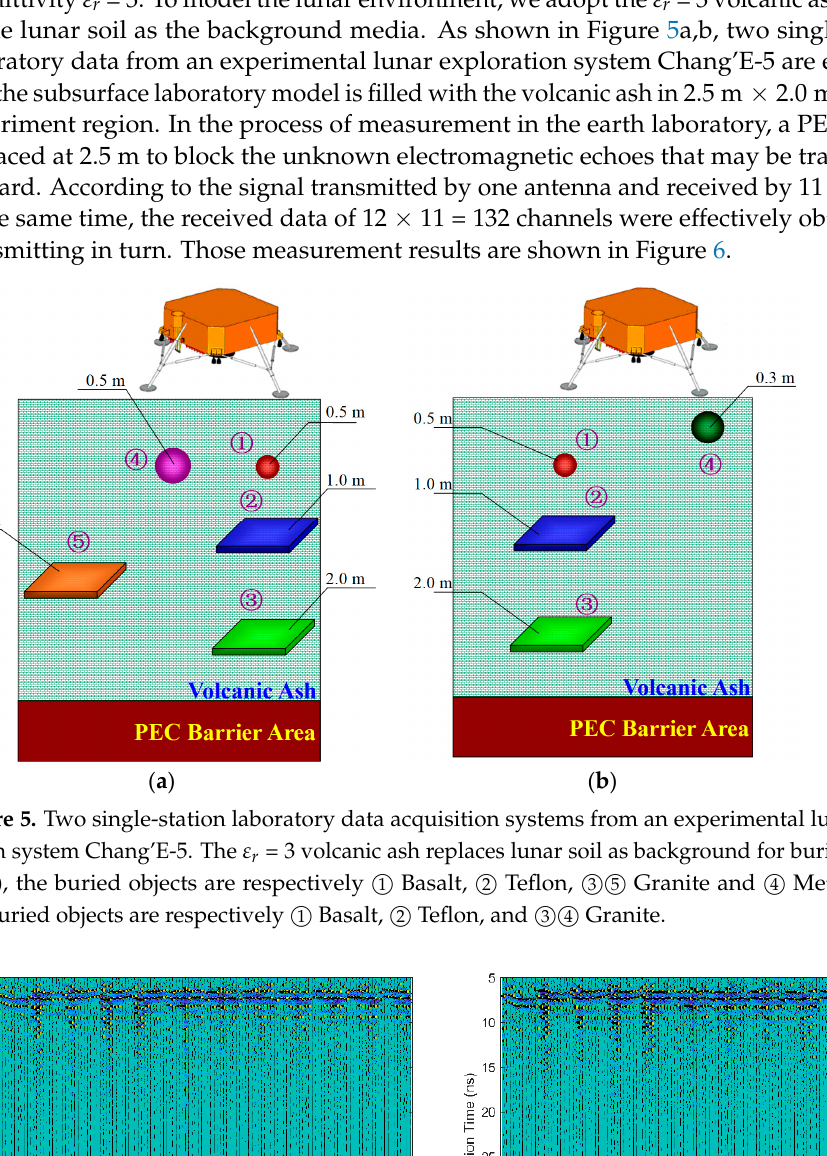
( b ) Figure 7. Two single-station measured data after the optimal Equation (36): ( a ) for Figure 5a, and ( b ) for Figure 5b, respectively. In the real laboratory measurement, excitation signals can be transmitted from the Chang’E-5’s UWBR system and recorded from the channel antenna. After the Chang’E-5 measurement is finished, the DZT-ME-SO-PML method can be applied to implement the subsurface imaging, shown in Figure 8a,b. The aim of reverse-time migration is to find the